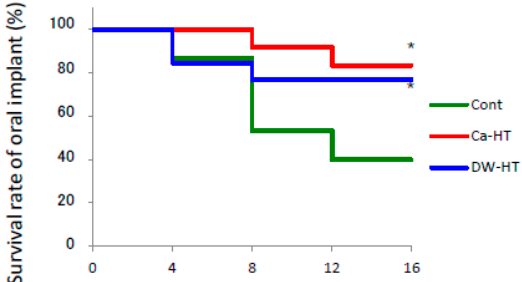
Figure 5. Survival rate at 4–16 weeks. The rate in the Cont group was dramatically decreased after 8 weeks. The Ca-HT and DW-HT groups were similar in change, but in both cases reductions were slower than in the Cont group. Log-rank test. * P < 0.05 vs.